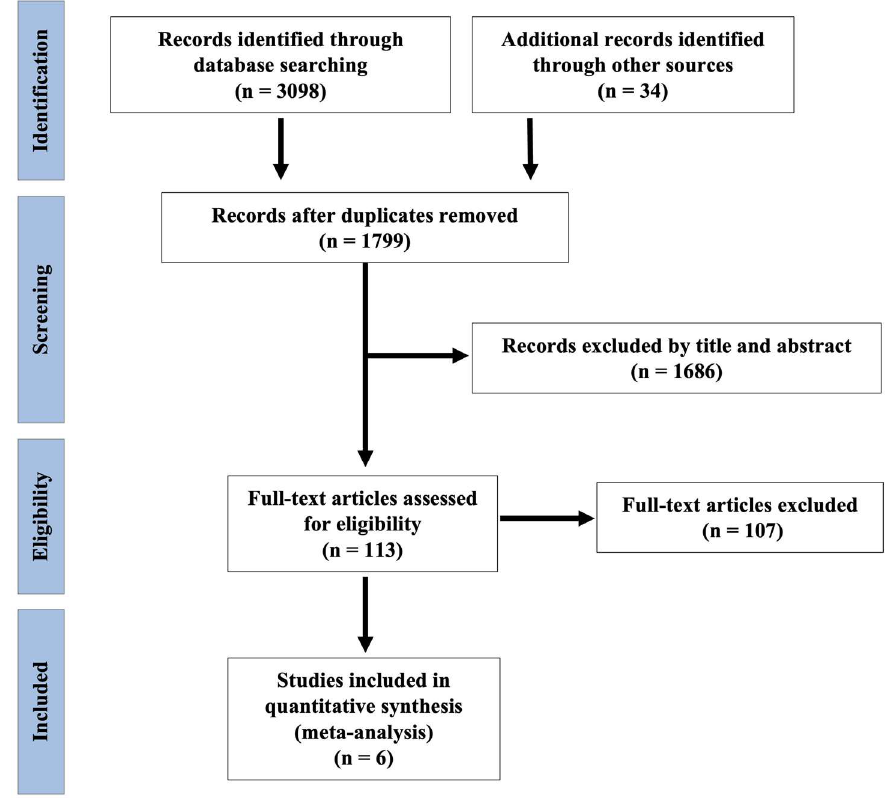
Figure 1. Preferred Reporting Items for Systematic Reviews and Meta-Analyses (PRISMA) flow diagram.